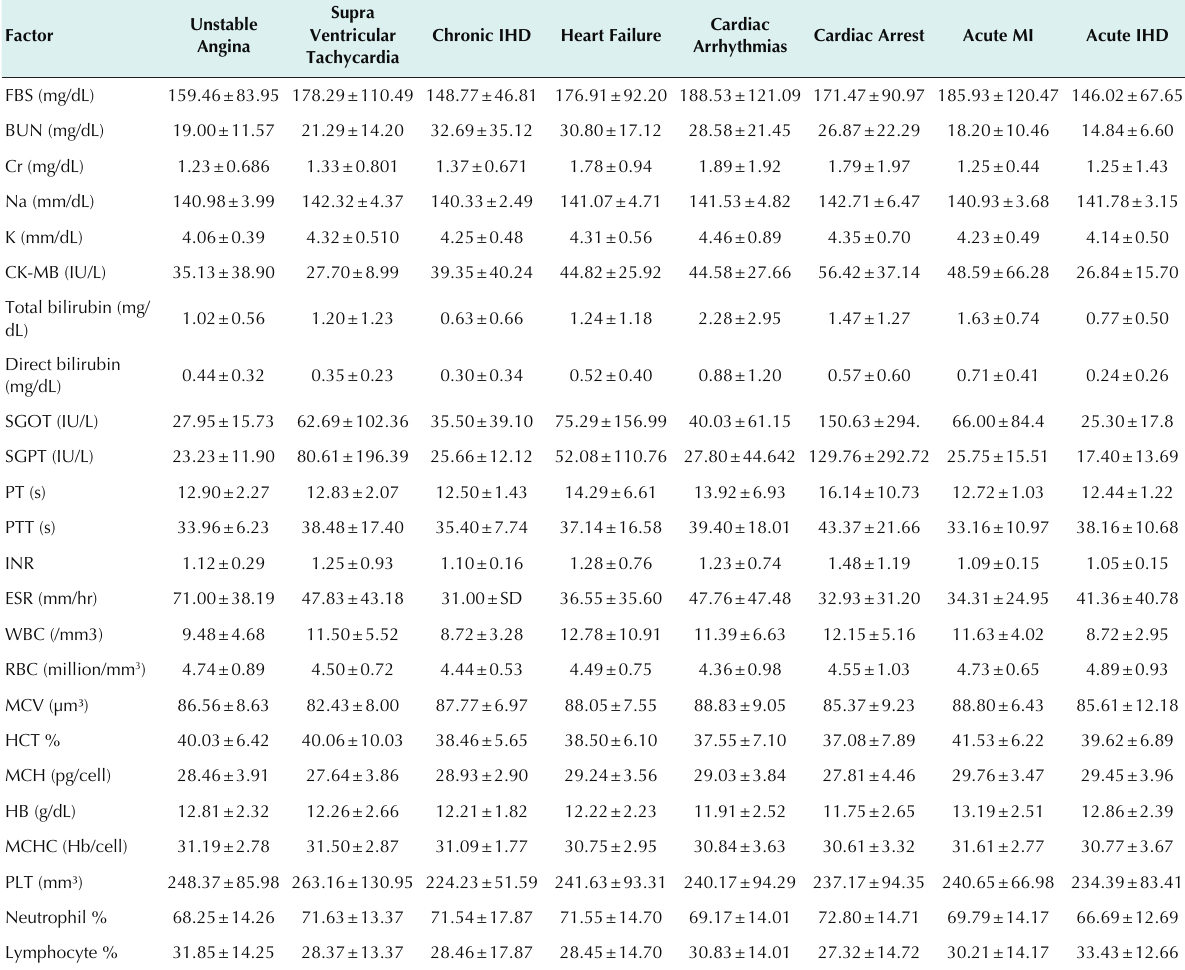
Table 5. Mean and Standard Deviation of Factors Studied in Different Types of Patients With Cardiovascular Diseases